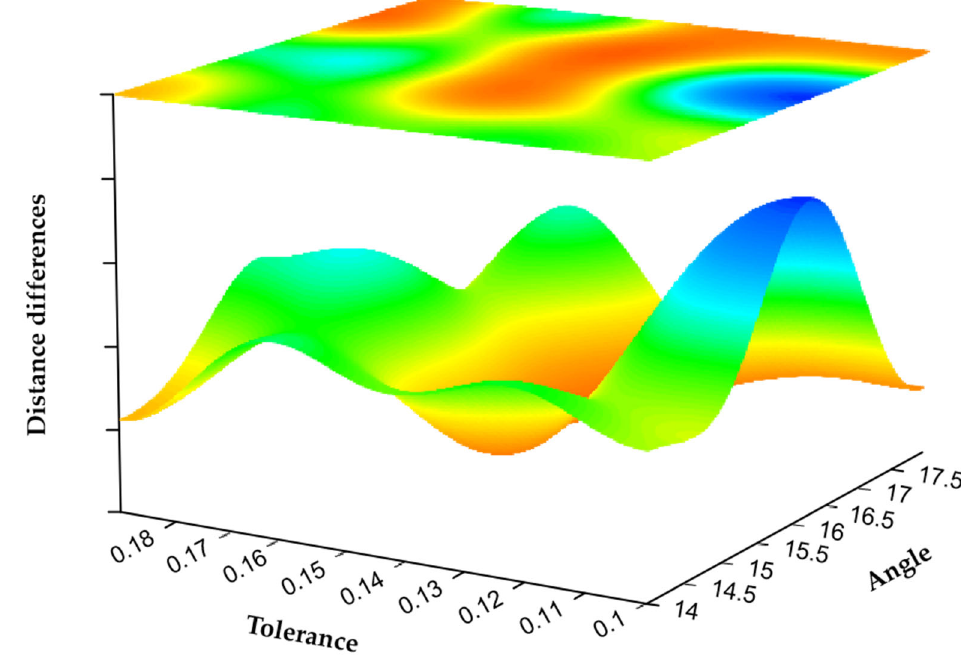
Figure 6. Registration error of different parameters.